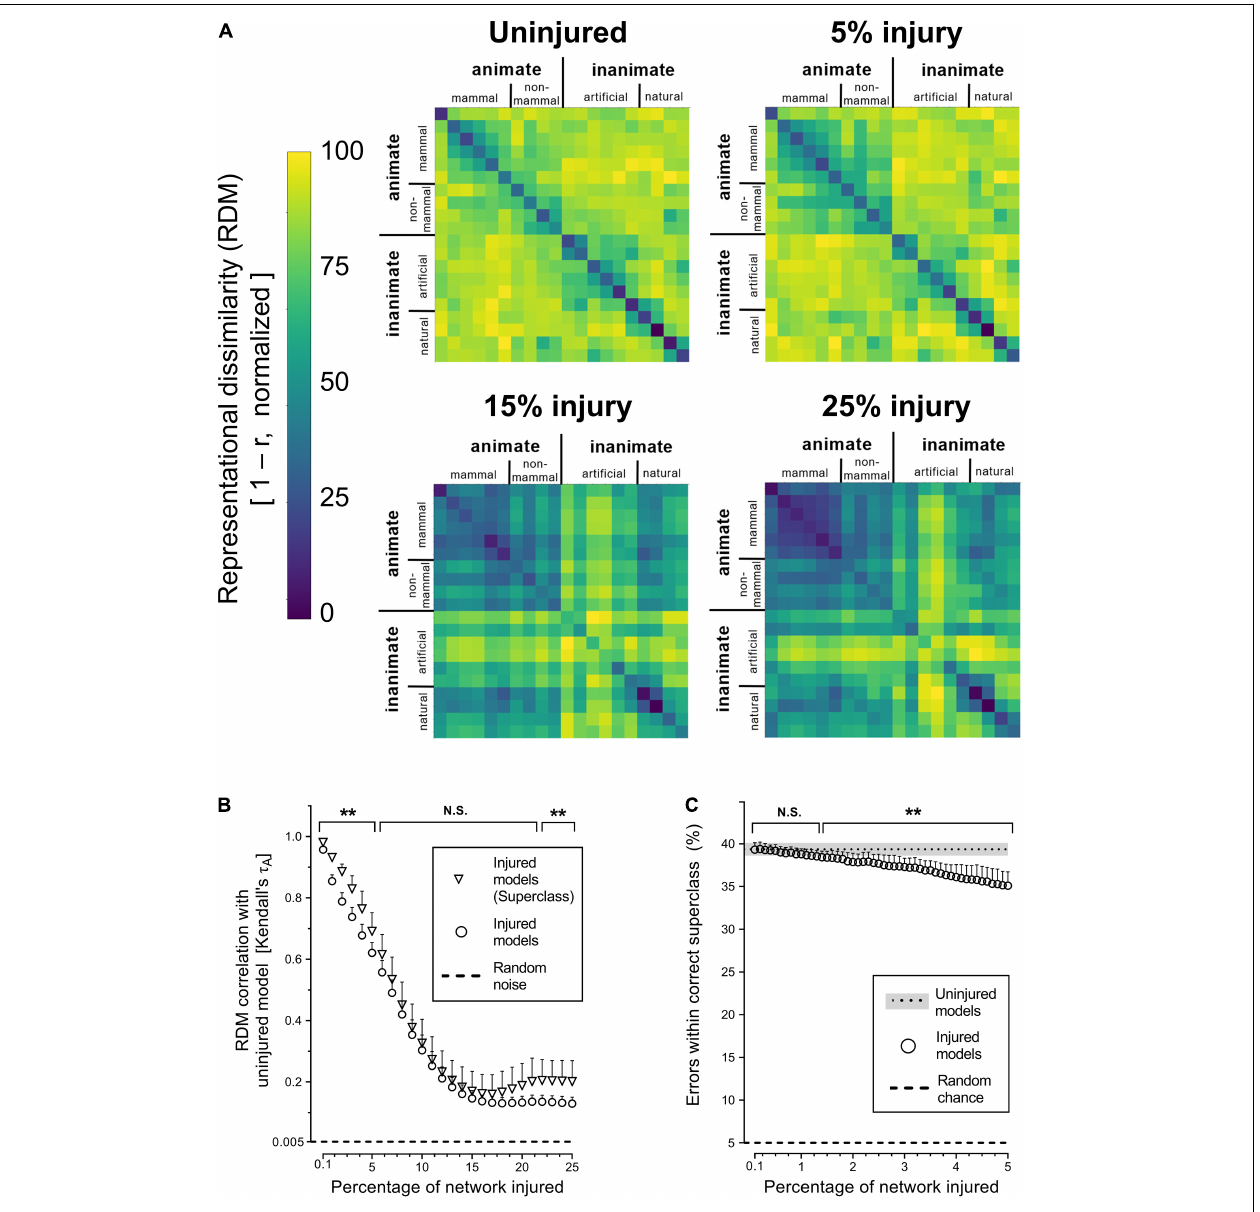
FIGURE 3 | Degenerating neural networks retained generalized information better than specific details. (A) Representational similarity of objects within a categorical superclass. The RDMs visualized are the average of the 25 trained networks. (B) Changes in internal activity patterns, relative to uninjured control models, at the object and superclass-level measured using Kendall’s τ A correlation coefficient. (C) Percentage of misclassified objects that were within the correct categorical superclass. Data are shown as mean + SD, n = 25 models, ** P < 0.01 using two-way ANOVA (B) or one-way repeated measures ANOVA (C) with Bonferroni’s correction for multiple